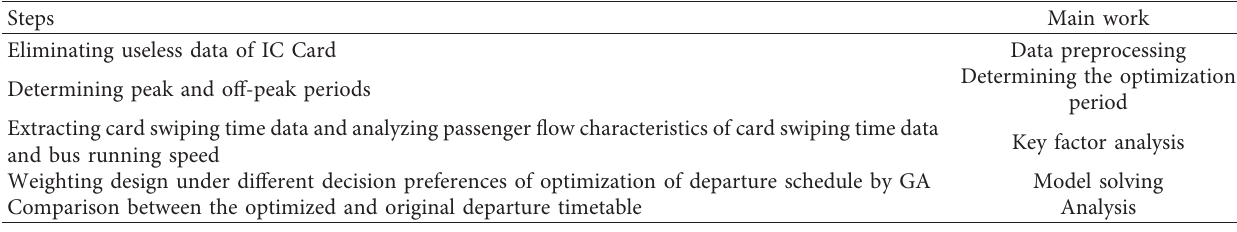
Table 1: Problem-solving